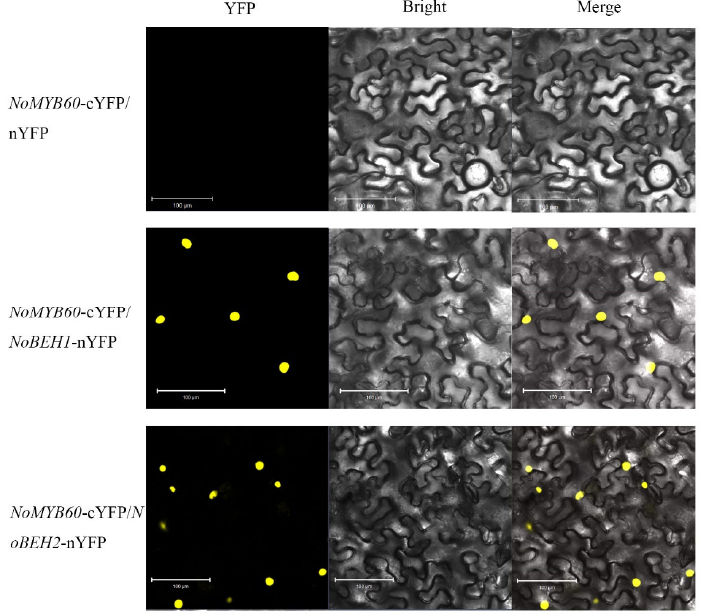
Figure 9. BiFC analysis of the interaction between NoMYB60 and NoBEH1/2 in tobacco leaves. The yellow fluorescence signal is displayed in a dark field, bright field and merged, respectively. Scale bar, 100 μ m.